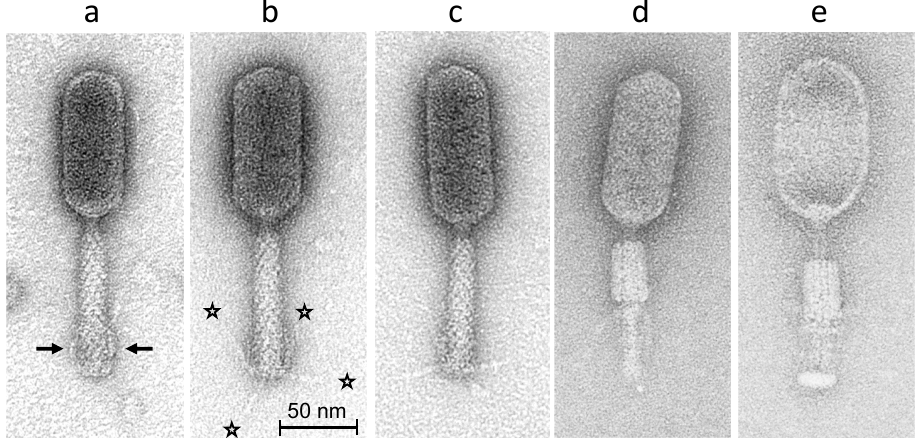
Figure 1. Transmission electron micrographs of phage S144 negatively stained with 2% ( w / v ) uranyl acetate. Three intact phage particles with extended tail sheaths are shown in ( a – c ) with short and notably rigid tail fibers attached to the distal tail region in upward position (i.e., in retracted configuration indicated by arrows in ( a ) or in (randomly) extended configurations (( b , c ); see asterisks in ( b )). Phage particles with contracted tail sheaths are shown in ( d ) (with intact capsid) and in ( e ) (with empty capsid). Bar represents 50 nm, as indicated.